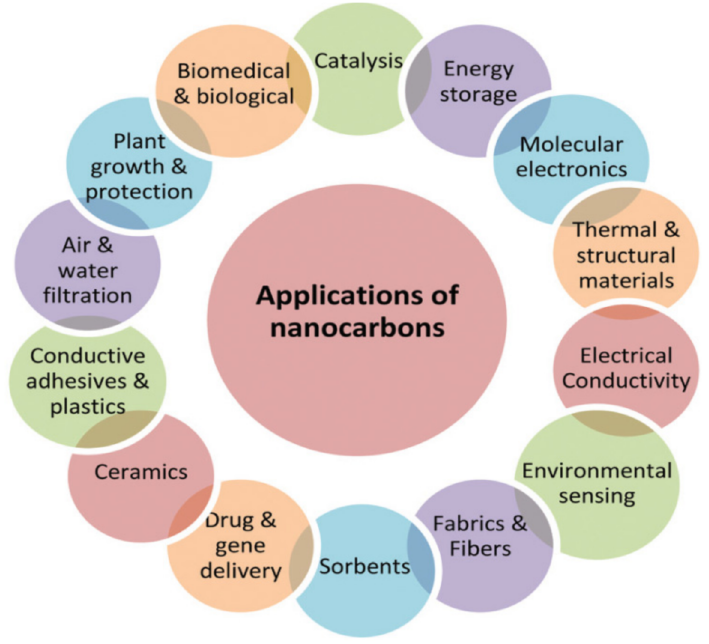
Figure 4. Applications of carbon nanomaterials in various fields [30].